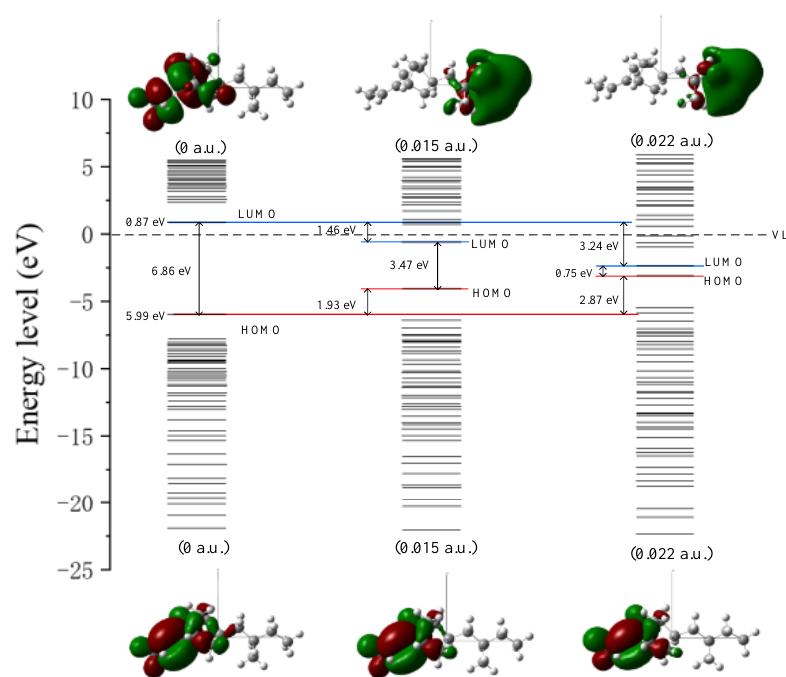
Figure 7. The energy level distribution and the frontier orbit of ENB-EPDM.